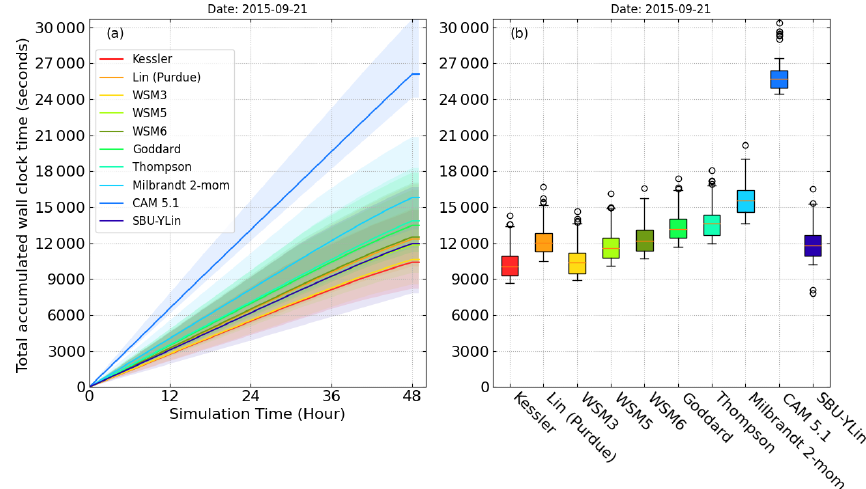
Figure 4. The (a) total accumulated simulation time. (b) A box plot of different microphysics configurations within each simulation hour on 21 September 2015. The upper and lower boundaries of the color fill indicate the maximum and minimum simulation time with other physics